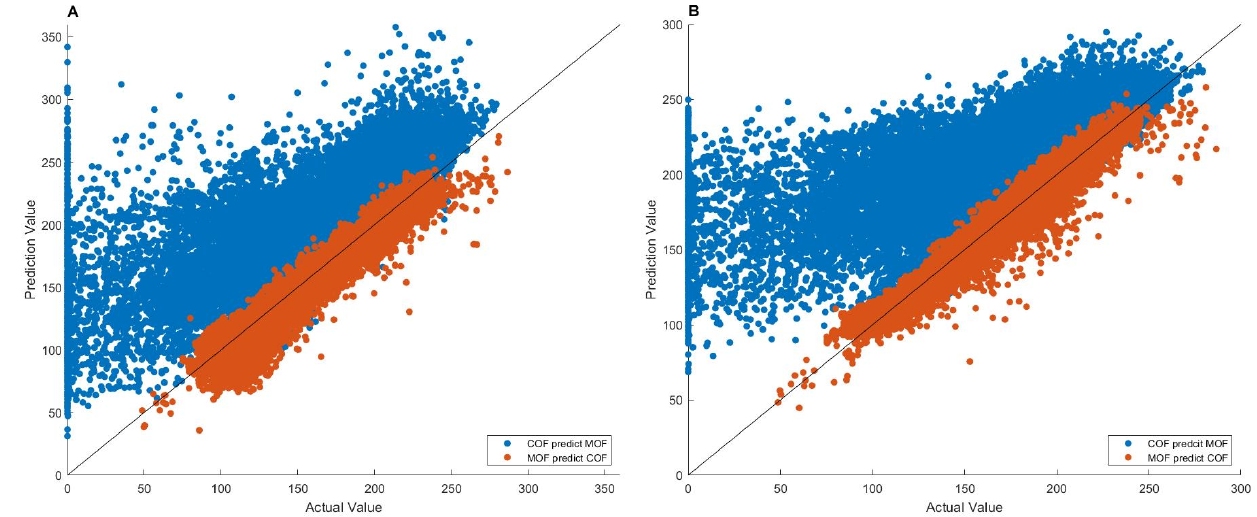
Figure 5. Transferability of MLP ( A ) and LSTM ( B ) models. The x-axis gives actual value and the y-axis depicts predicted value. The values are the volumetric-based adsorption capacities in units of cm 3 (STP)/cm 3 . The blue points are adsorptions of MOFs predicted by models trained on COFs, while the red points are adsorptions of COFs predicted by models trained on MOFs.